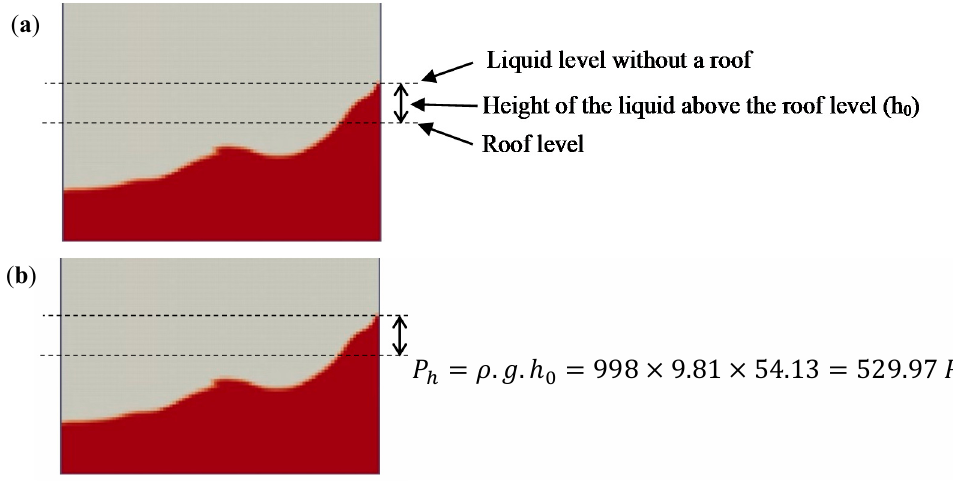
Figure 17. Hydrostatic pressure calculation method for the tank with high walls: ( a ) schematic view; ( b ) sample calculation for the tank with high roof filled to 100 mm and excited by the El Centro ground motion.